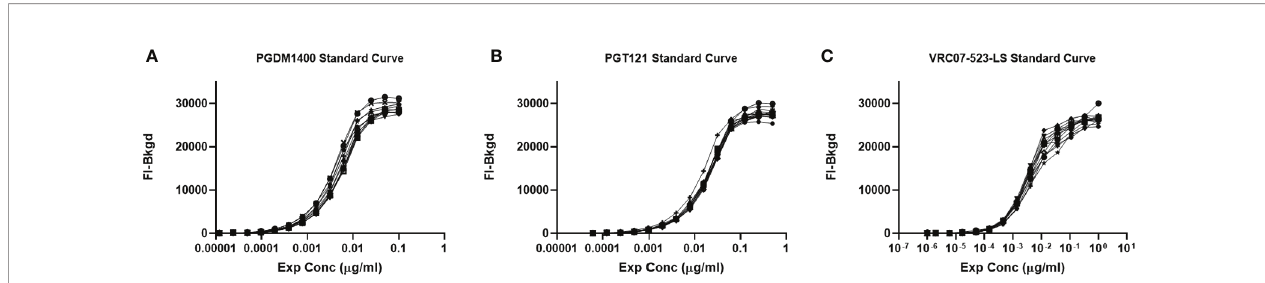
FIGURE 8 | Repeatability of the PGDM1400/PGT121/VRC07-523-LS standard curve. PGDM1400, PGT121 and VRC07-523-LS were co-titrated in 1:100 NHS in assay diluent for a total of 12 repeats by the same operator. Curves for PGDM1400 (A) , PGT121 (B) and VRC07-523-LS (C) are graphed to demonstrate the repeatability of this